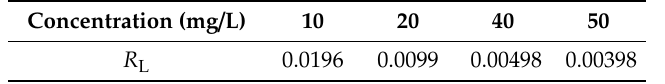
Table 5. R L value of methyl orange adsorbed by CS/GO aerogel.